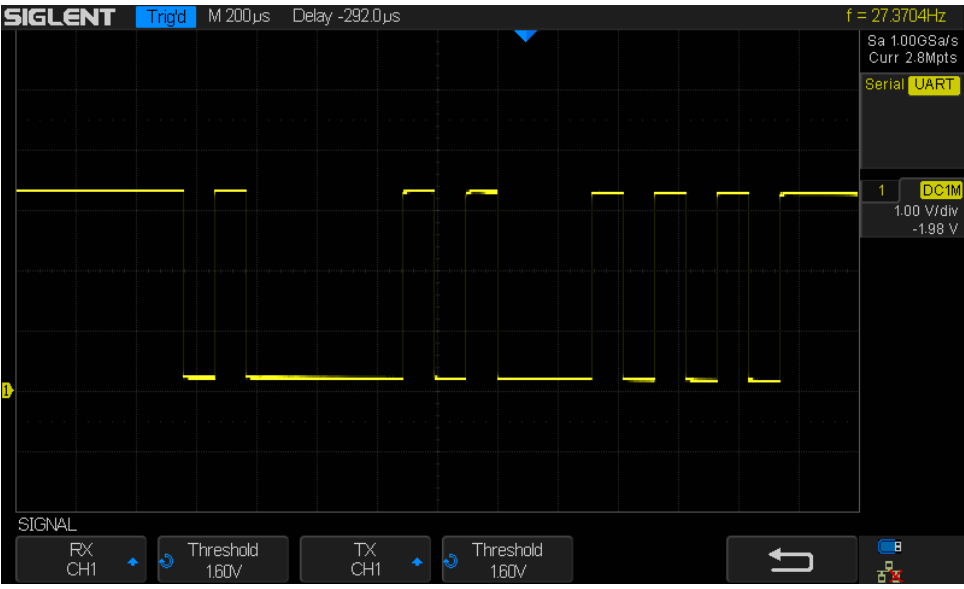
Figure 15. Sending sample value—“AT”—to verify Bluetooth transmission. As it is seen in the